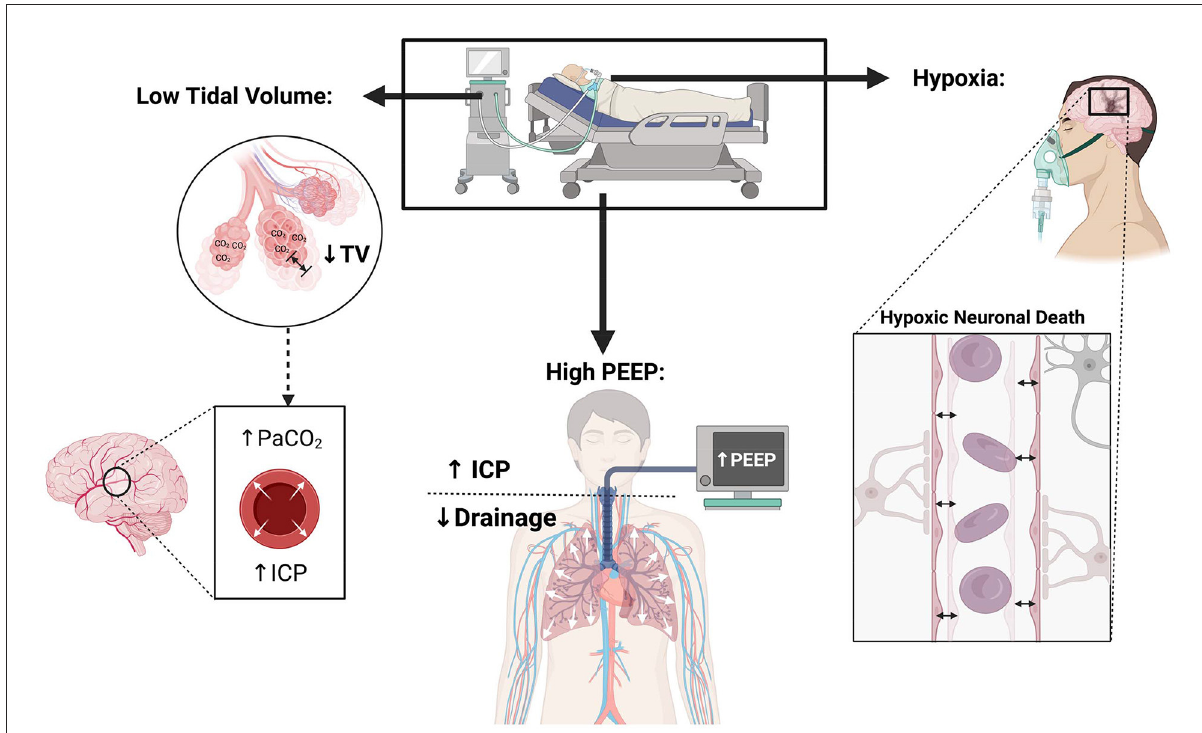
FIGURE1 Physiological consequences of lung protective ventilation in patients with neurological